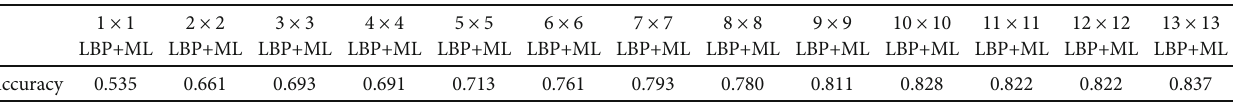
Table 6: Average classi fi cation accuracy of “ LBP feature+manifold learning ” in 5 times 10-fold cross